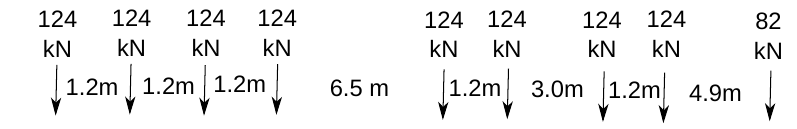
Figure 2. Factored axle loads acting on a beam from the 1-2-2-4 vehicle.